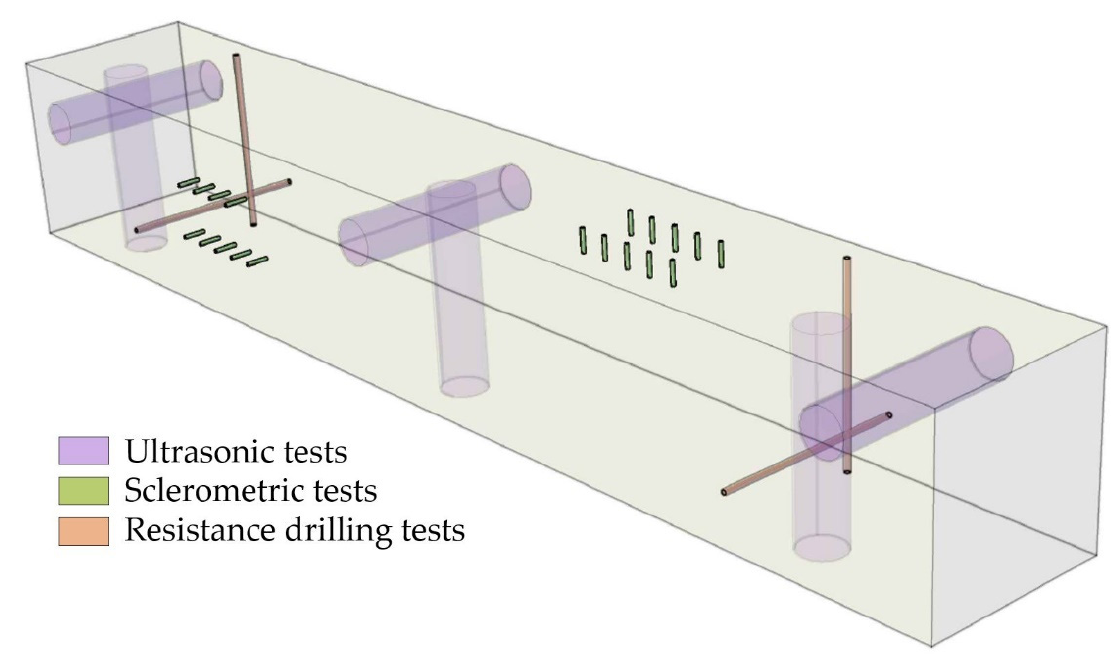
Figure 1. A diagram of a sample.